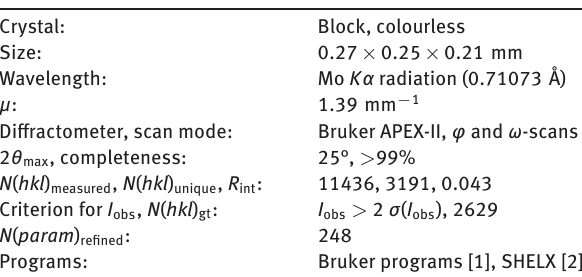
Table 1: Data collection and